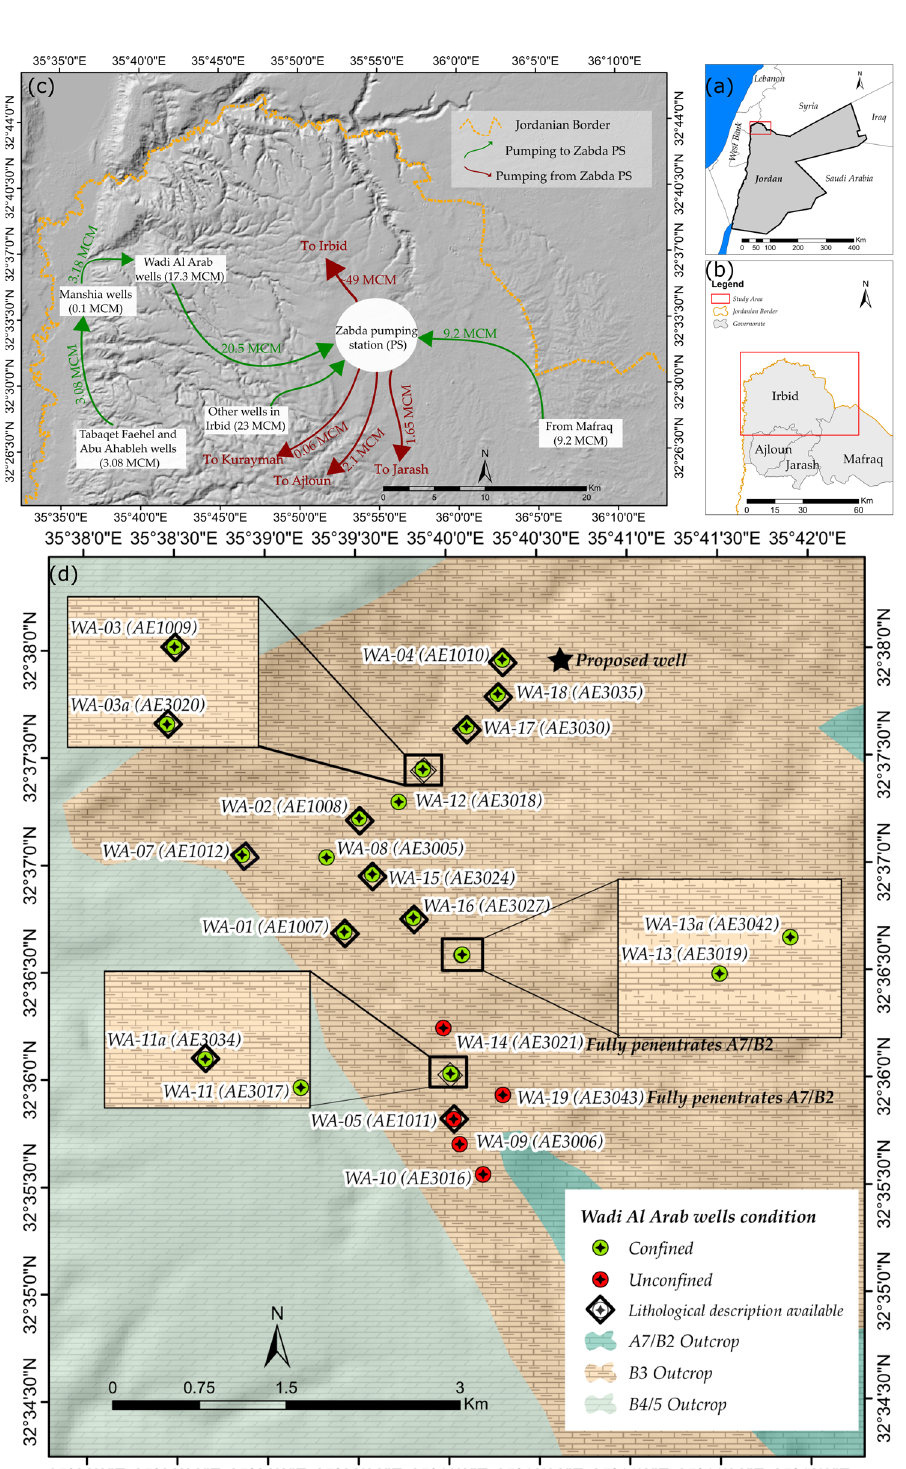
Figure 1. Overview map of the study area. ( a ) The location of Jordan and surrounding countries ( b ) The area of Irbid governorate and the study area. ( c ) Schematic diagram showing the regional water supply system in 2017 (modified after [82]) and ( d ) The Wadi Al Arab well confinement condition and lithological availability map.